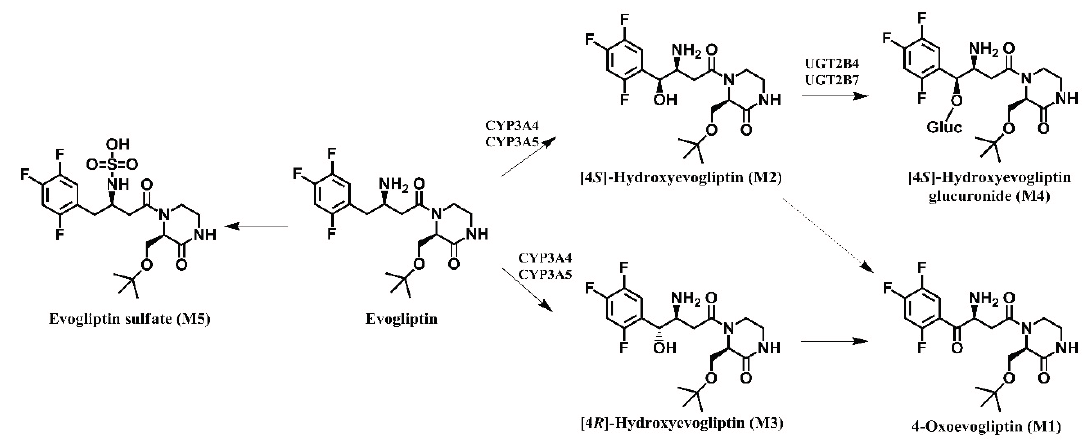
Scheme 1. Possible metabolic pathways of evogliptin in human hepatocytes, liver microsomes and liver S9 fractions.